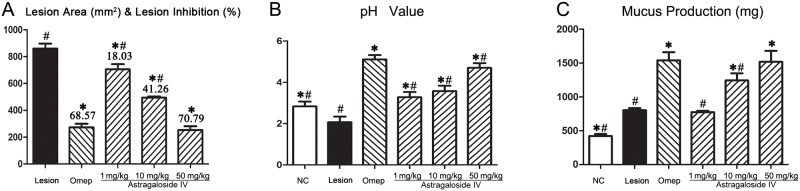
The effects of astragaloside IV treatment on the gastric lesions area, pH value and mucus production.Astragaloside IV or omeprazole were administered 1 h prior to WRS-induced gastric lesion to assess the protective effect. Lesion control group rats received Tween 80. After 12h, rats were sacrificed and lesion area, pH value and mucus production were measured. NC, negative control; Lesion, Lesion control; Ome: omeprazole. Data expressed as mean ± standard error of mean. *Significant difference (P< 0.05) when compared with the lesion control (group 2), #Significant difference (P< 0.05) when compared with the omeprazole (group 3) using one-way ANOVA followed by Tukey-Kramer Multiple Comparisons Test.